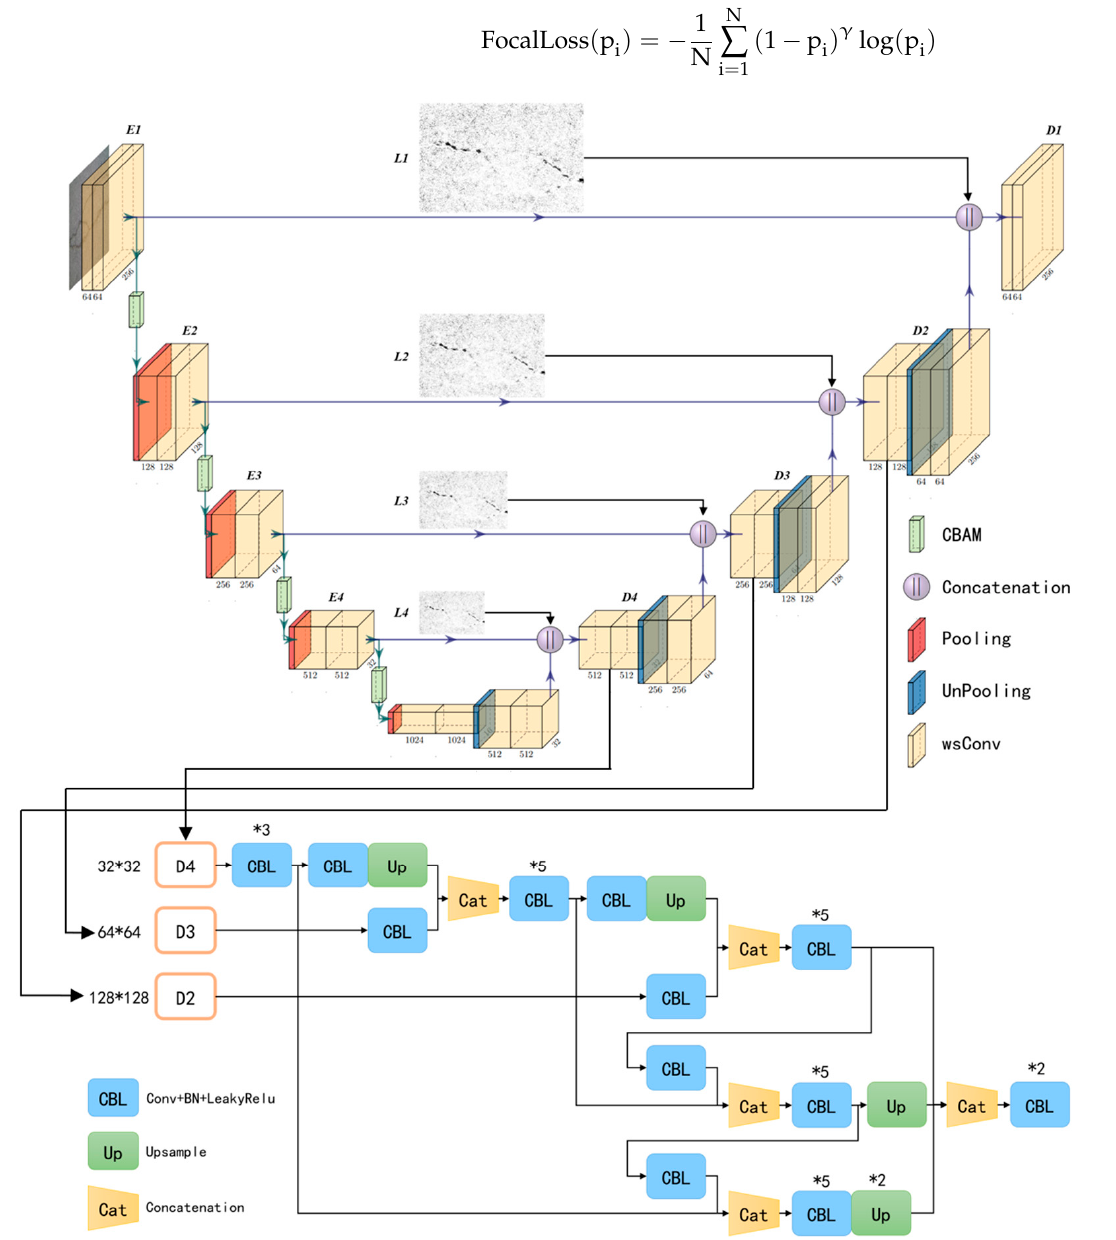
Figure 2. The ALP-UNet structure.